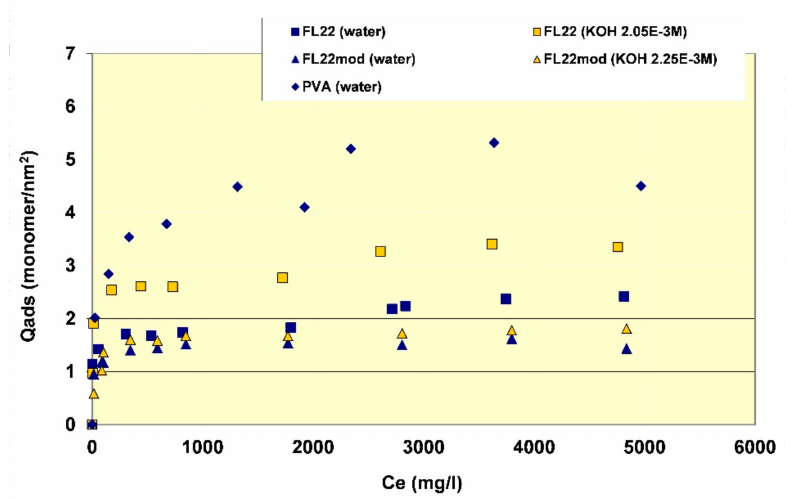
Figure 8. Surface coverage of the polymers tested on kaolinite as a function of equilibrium concentration of polymer in